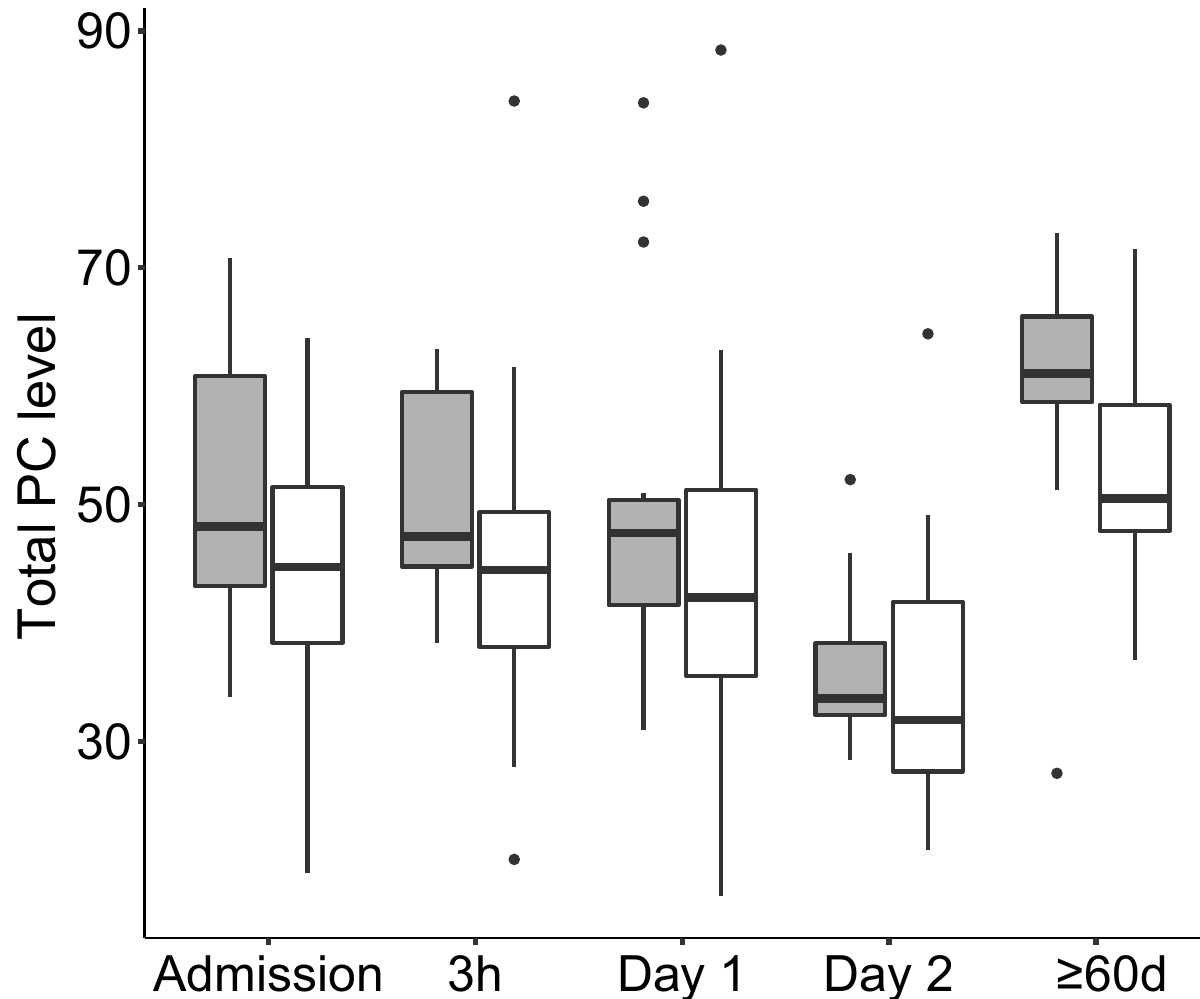
Fig 5. Boxplot diagram showing the distribution of total PC levels at the different sampling time points from admission to full recovery after � 60d. Females are shown in gray boxes and males in white boxes. The PC levels are relative to the known concentration of the IS LPC 19:0. Outliers are shown as dots. Abbreviations: PC,